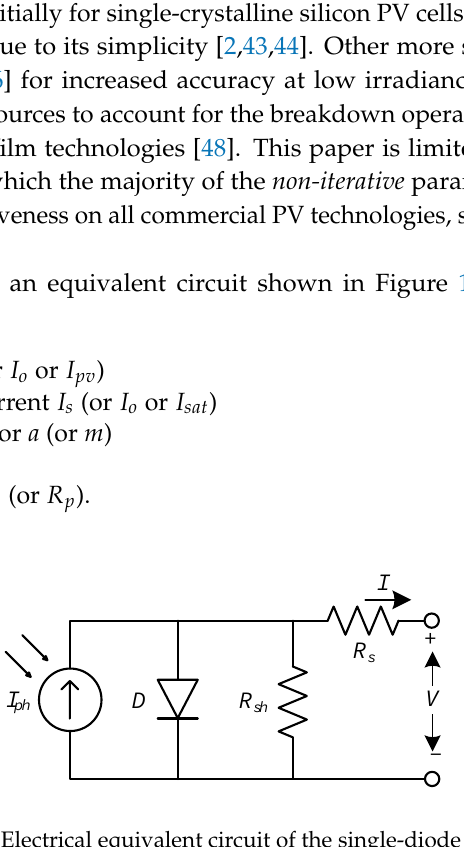
Figure 1. Electrical equivalent circuit of the single-diode PV